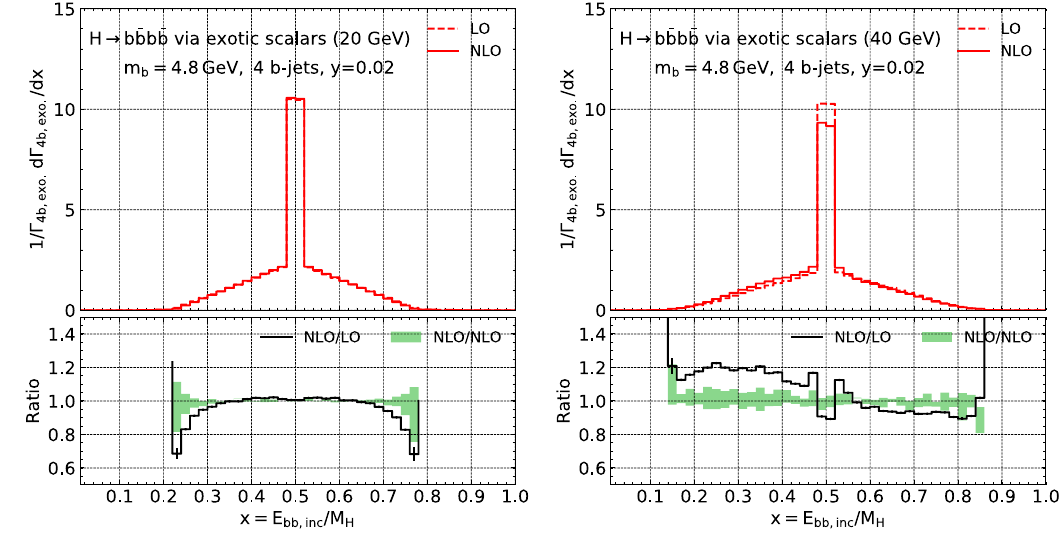
Figure 21 . Similar to figure 20 for distribution as a function of the inclusive energy of all b -jet